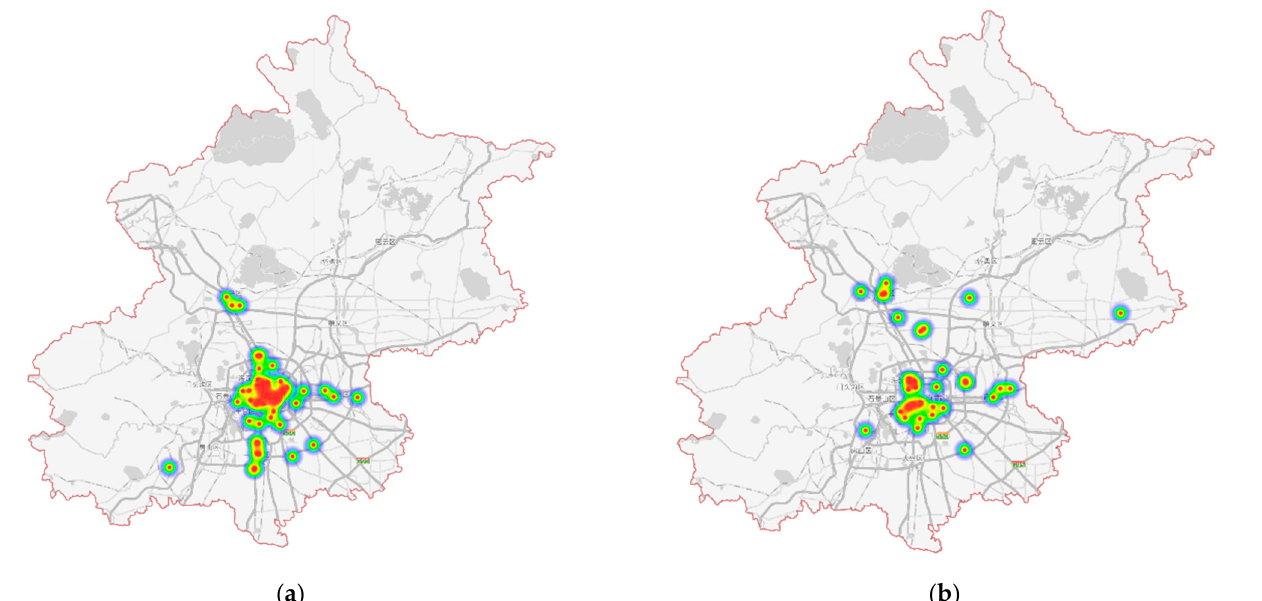
Figure 12. ( a ) Heat map of the distribution of pseudo-public space markers (before the outbreak); ( b ) heat map of the distribution of pseudo-public space markers (during the outbreak).